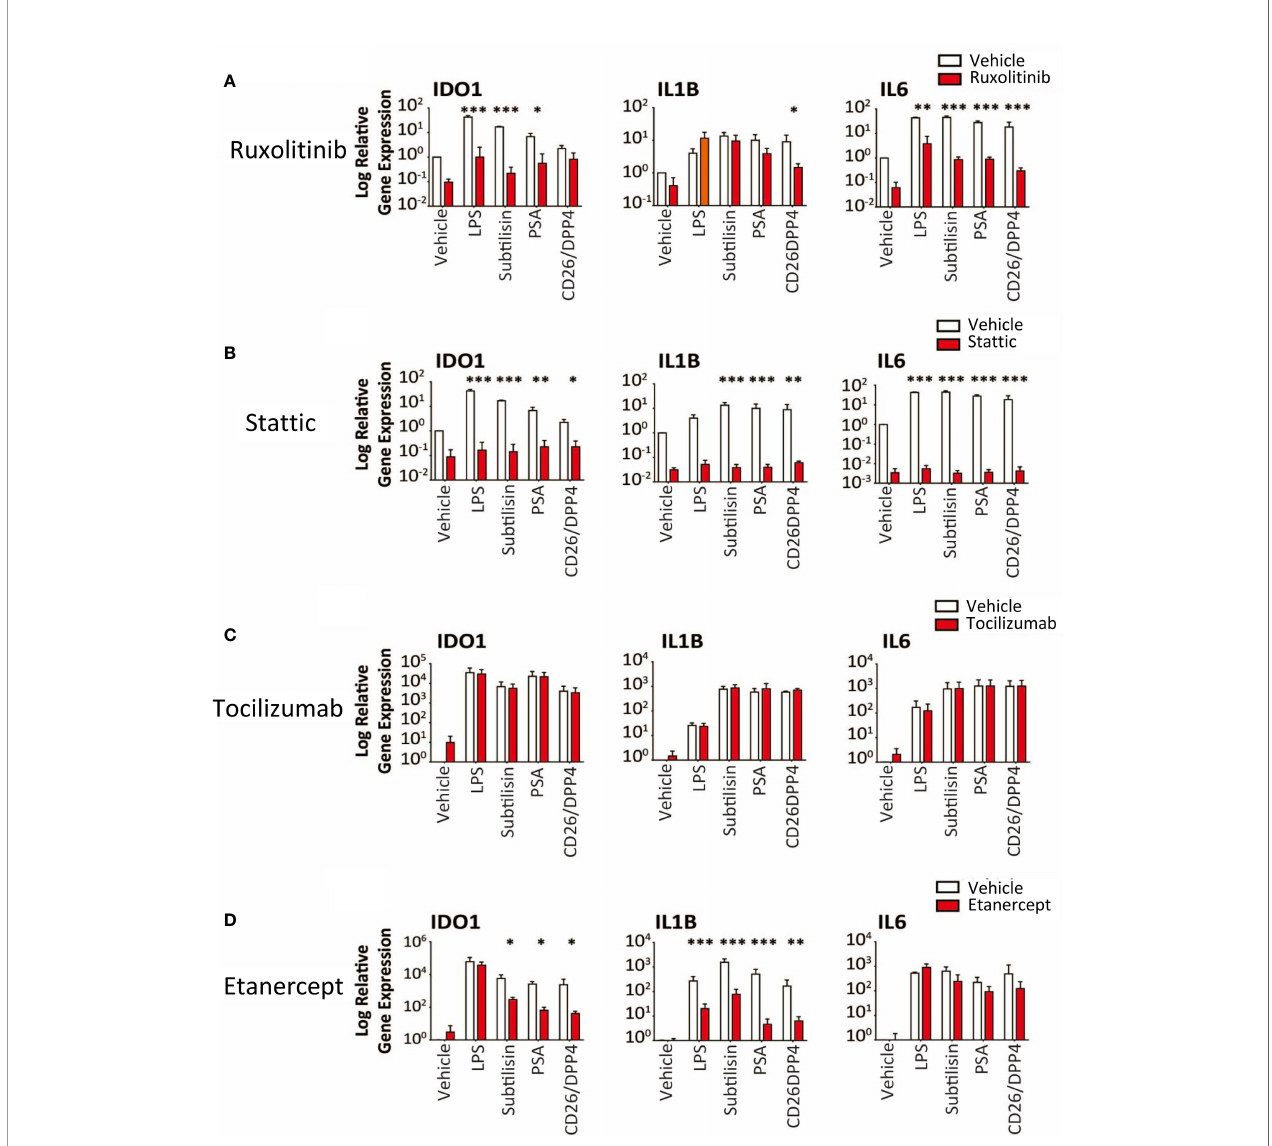
FIGURE 7 | Transduction pathways affected by serine proteases. The logarithmic expression of IDO1 , IL1B and IL6 induced by vehicle, LPS (10 ng/mL), subtilisin (20 nM), PSA (100 nM) and CD26/DPP4 (10 nM) in the presence of vehicle (open bars) or test agents (red/shaded bars): (A) Ruxolitinib (20 m M), (B) stattic (10 m M), (C) tocilizumab (20 m g/mL), (D) etanercept (20 m g/mL). Bars show the mean ± s.e.m. The number of experiments (n) was 3 in all cases except panels C and D, where n = 6. *P < 0.05, **P < 0.01; ***P <